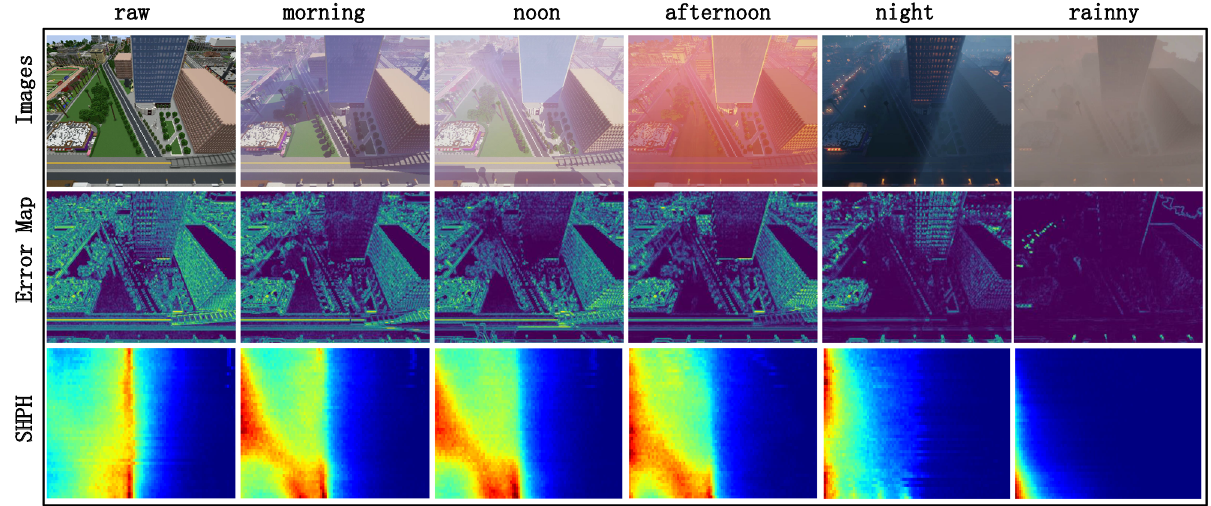
Figure 10. Sequence under different lighting conditions. Photometric error map (row 2) and SHEH map (row 3).